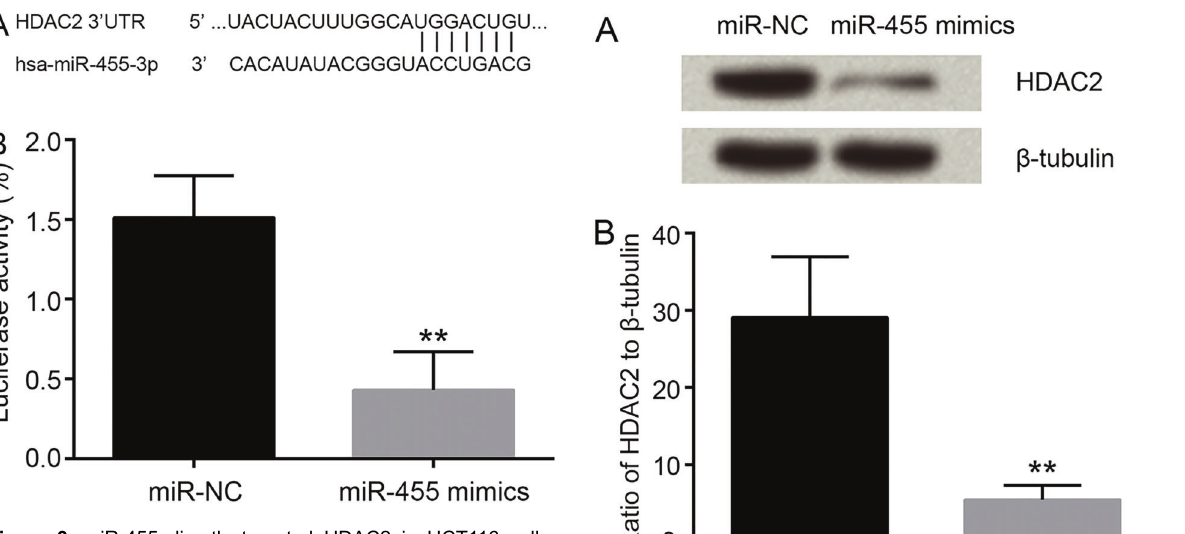
Figure 3. miR-455 directly targeted HDAC2 in HCT116 cells. A , Diagram showing miR-455 formed base-pair with the 3 0 UTR of HDAC2. B , Luciferase activity of cells co-transfected with pmirGLO vector containing 3 0 UTR segment of the HDAC2 and miR-NC or miR-455 mimics. Data are reported as the mean ± SD of 3 indepen- dent experiments. **P o 0.01 (two-tailed unpaired t -test). HDAC2: histone deacetylase 2; 3 0 UTR: 3 0 -untranslated region; miR-455 mimics: microRNA-455 mimics; miR-NC: negative control of miR-455.